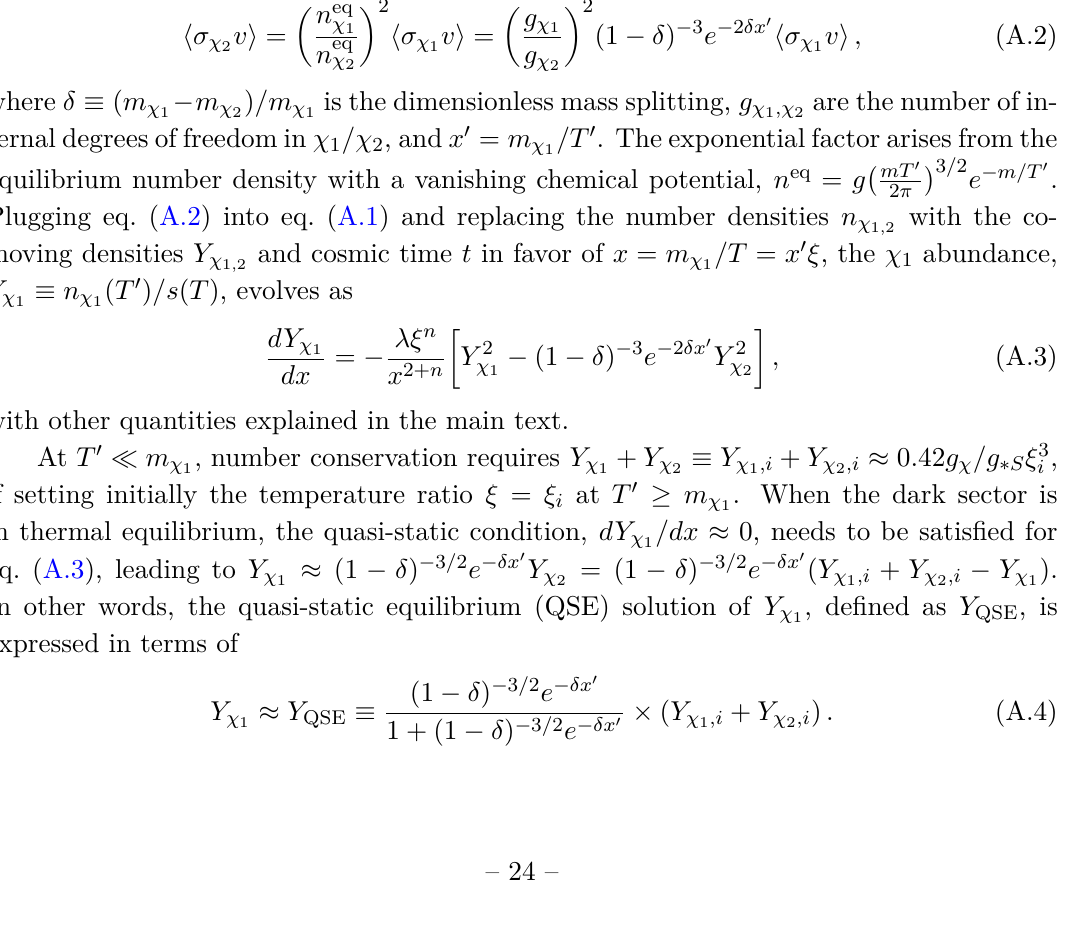
Figure 12 . Evolution of dark temperature T 0 in the nearly degenerate scenario, where the couplings are fixed to g 1 g 2 /m 2 = 1 / (4 TeV ) 2 and m χ = 1 TeV, while the left panel takes δ = 0 . 1 , ξ i = 0 . 01 , A 1 and the right takes δ = 0 . 01 , ξ i = 0 . 1 . The red lines give exact values of T 0 , normalized to m χ from numerically solving the Boltzmann equations. In contrast, gray dotted lines give a simple T 0 ∝ T scaling from its initial value at T 0 (cid:29) m χ , while gray dashed lines show the values from 2 ( m χ /T 0 ) = β ( m χ /T ) 2 of eq. (2.9). It verifies that eq. (2.9), with the scaling T 0 ∝ T 2 , works well 1 1 in the regime of T 0 (cid:28) m χ 2